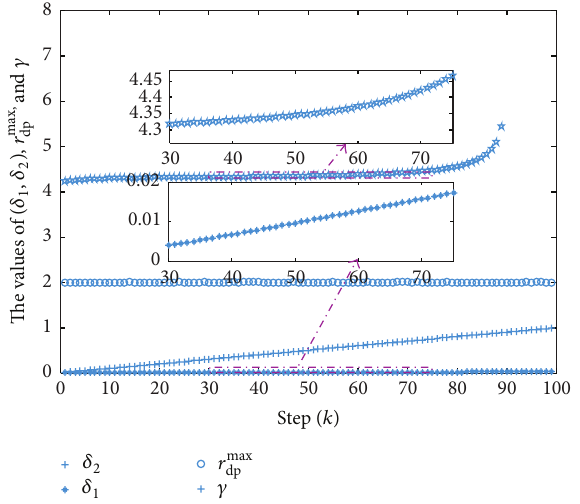
Figure 2: The relationships among 𝛿 1 , 𝛿 2 , 𝑟 dp , and 𝛾 .